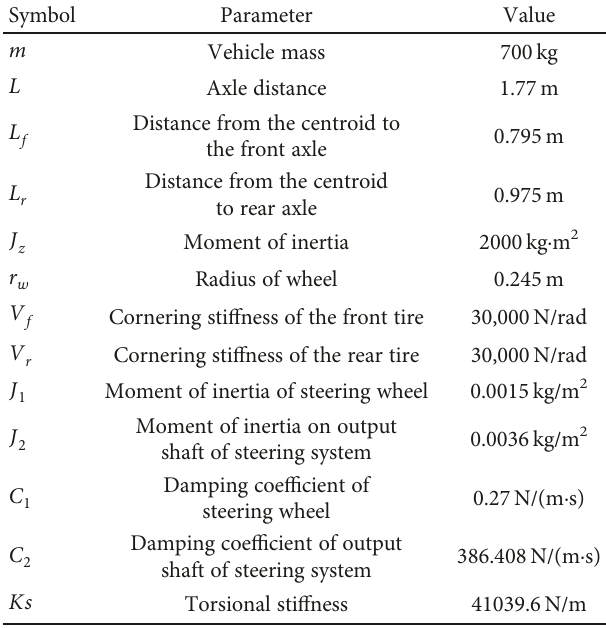
Table 1: Vehicle